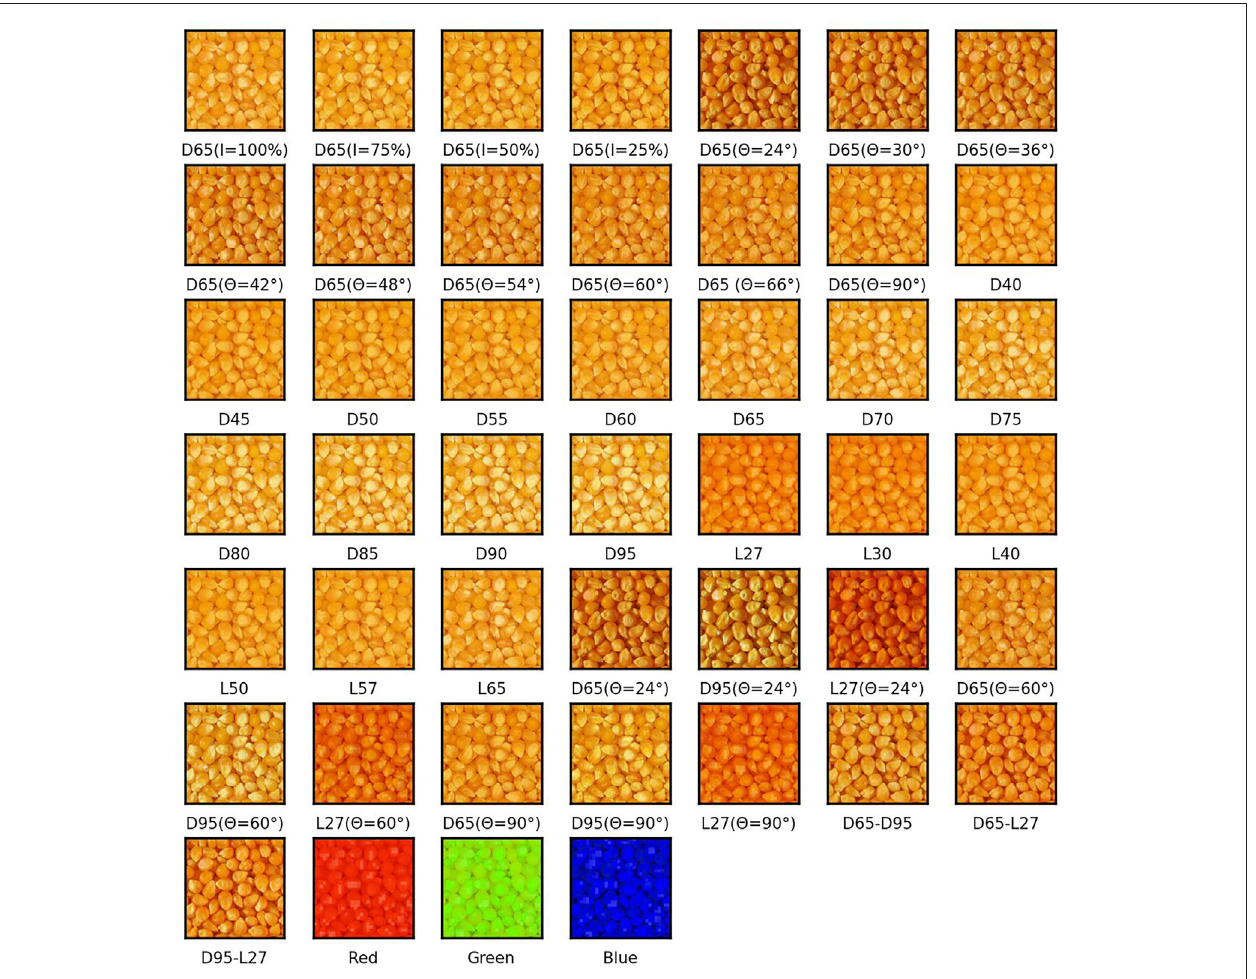
FIGURE 3 | Image of the corn sample set after